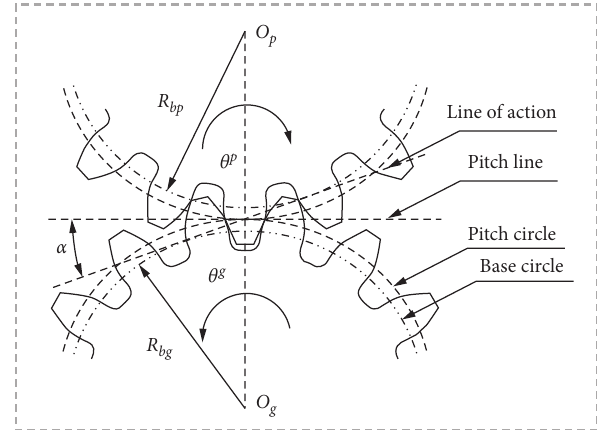
Figure 2: Gear motions along the